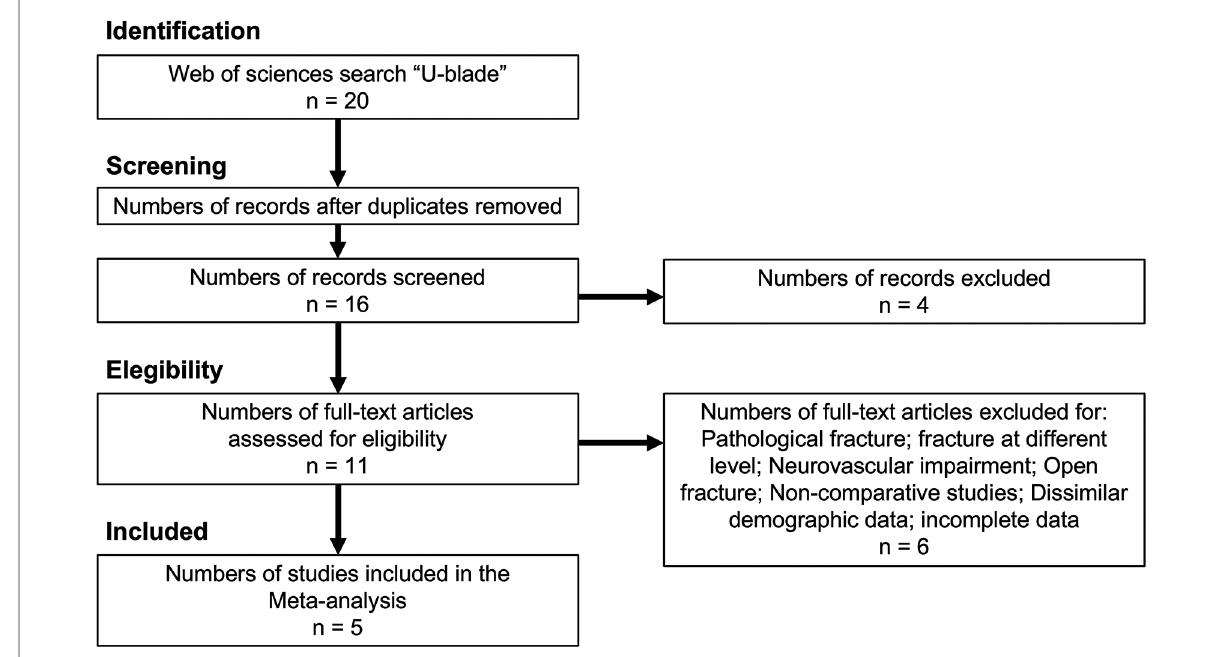
FIGURE 1 Study selection fl ow diagram (Preferred Reporting Items for Systematic reviews and